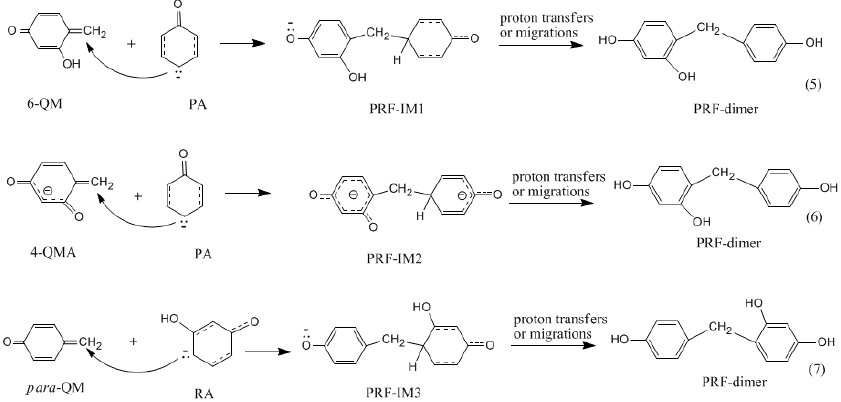
Figure 13. The Michael addition reactions of phenol anion (PA) with resorcinol quinonemethides (6-QM and 4-QMA) and the reaction of resorcinol anion (RA) with phenol quinonemethide ( para -QM).